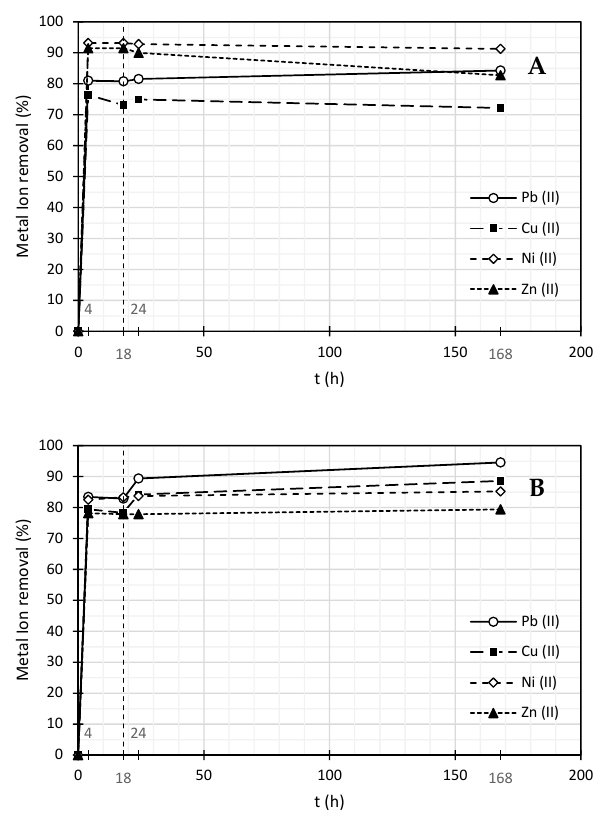
Figure 4. Metal ions removal by adsorption in suspensions with 0.01% ( w / w ) of MWCNTs and 0.03% ( w / w ) of SDBS ( A ), 0.03% ( w / w ) of Pluronic F-127 ( B ), under competitive conditions between cations. Mixture of heavy metals: Initial concentrations Pb (II) ~4 mg/L, Cu (II) ~7 mg/L, Ni (II) ~3 mg/L and Zn (II) ~3 mg/L. Table 8. Removal of Pb(II), Cu (II), Ni (II) and Zn (II) by a suspension of 0.01% (w/w) of MWCNTs with 0.03% (w/w) of SDBS, under competitive adsorption conditions between cations. SDBS Cu Time (h) Pb (mg/L) Ni (mg/L) Zn (mg/L) (mg/L)